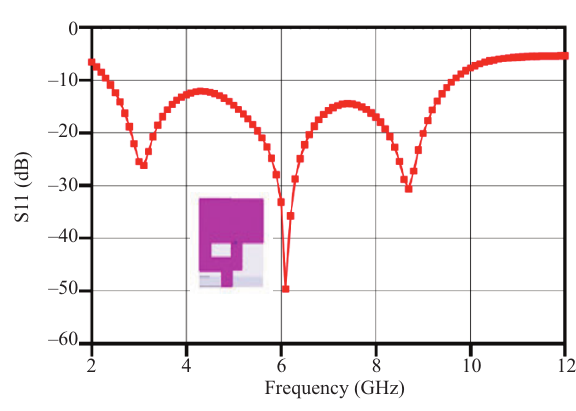
Fig. 2. Simulated S11 for the reference antenna with the band ­ width ranging from 2.4 GHz to 9.6 GHz.